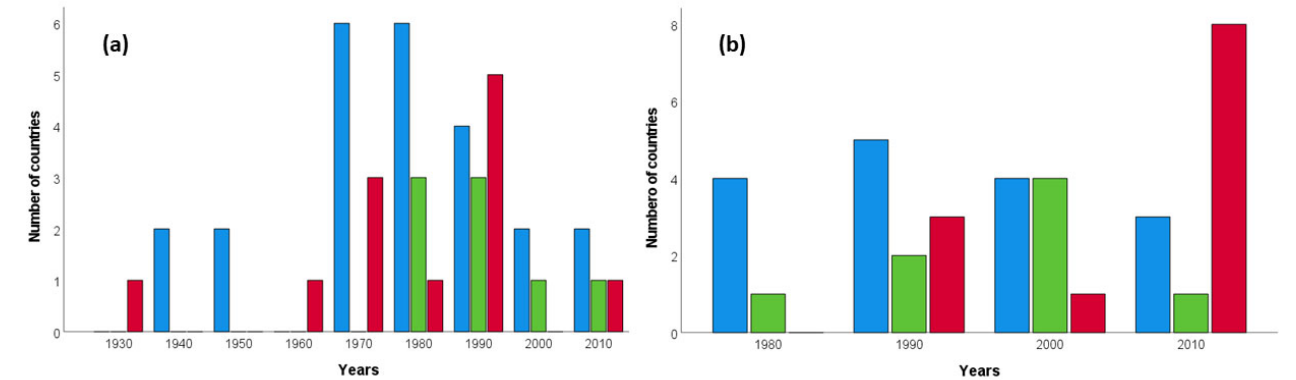
Figure 2. Years (grouped into decades) in which Neotropical countries ( a ) prohibited trapping wild parrots for the domestic demand of pets and ( b ) performed the last legal exports of wild-caught parrots for the international pet markets. Countries are grouped as Caribbean (blue bars), Central American (green bars) and South American (red bars).